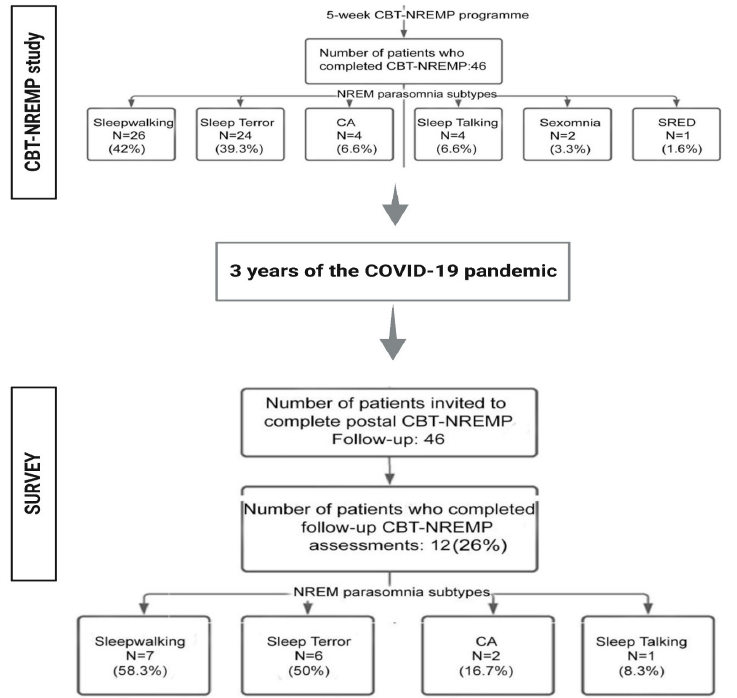
Figure 1. Flowchart of the studied cohort of patients with NREM parasomnia. Some patients reported two or more subtypes of NREM parasomnia. Percentages indicate the prevalence of each NREM parasomnia subtype in our cohort. CBT-NREMP: Cognitive Behavioural Therapy for NREM parasomnia; CA: confusional arousal; SRED: sleep-related eating disorder; NREM: Non-REM. However, longitudinal robustness and sustainability of CBT-NREMP intervention effects have so far not been investigated. Furthermore, it is unclear whether CBT-NREMP unique design is sufficient to provide longitudinal protection against significant traumatic events, such as the unique and unprecedented bio-psycho-social dimension of the ongo- ing COVID-19 pandemic [11]. Biological factors such as overt, unknown and latent effects of the infection, vaccines and the impact of long COVID-19 [12] on sleep and mental health [13,14], where relatively little is known about symptom severity, expected clinical course, impact on daily functioning and return to baseline health [15], were expected to have a detrimental impact. Moreover, throughout the pandemic, public health measures, includ- ing cessation of international, national and regional travel, lockdowns and restrictions, whilst implemented to reduce community transmission of the virus, have also had recog- nised neuropsychiatric consequences for the population as a whole, with forced social isolation and personal and professional uncertainty likely leading to an increase in re- ported insomnia and other sleep disorders, as well as psychiatric symptoms, including stress, anxiety and depression [11,14].